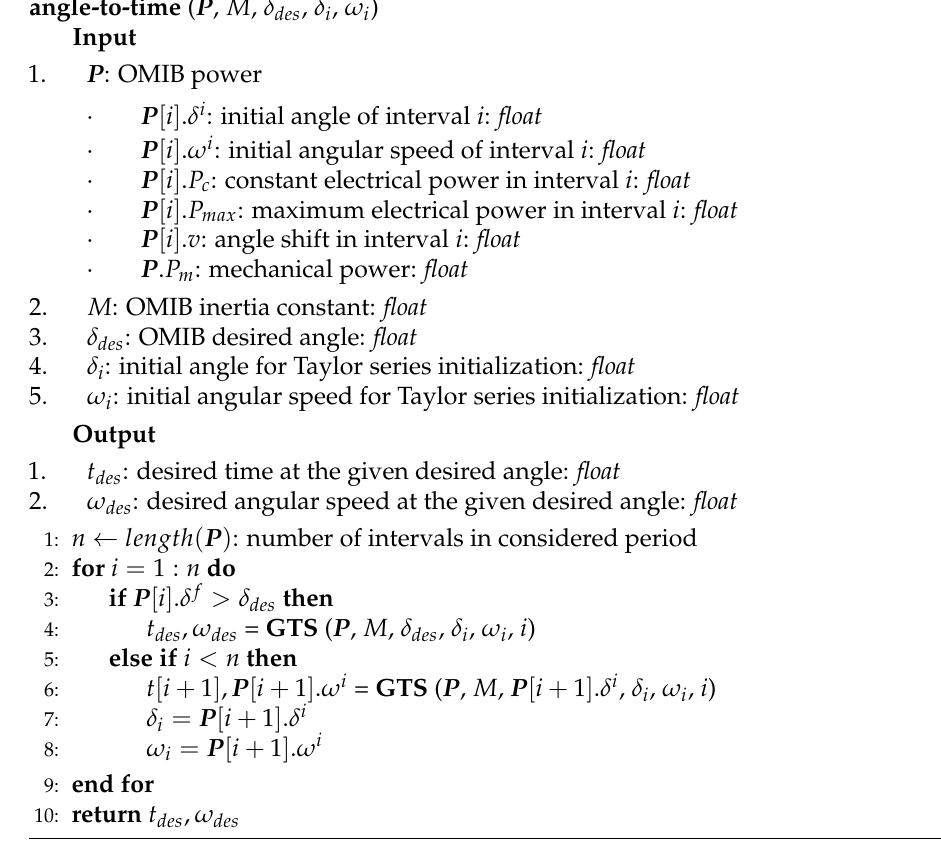
Algorithm A8 Finding the time and angular speed associated to a desired angle for the OMIB model using the global Taylor series angle-to-time ( P , M , δ des , δ i , ω i )